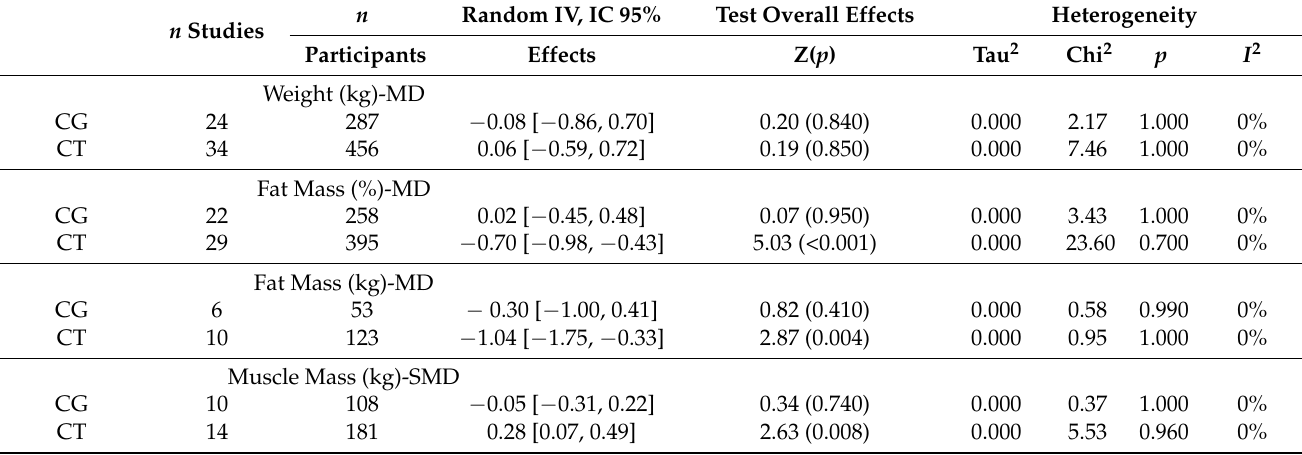
Table 2. Effect of resistance circuit training and endurance training on body composition